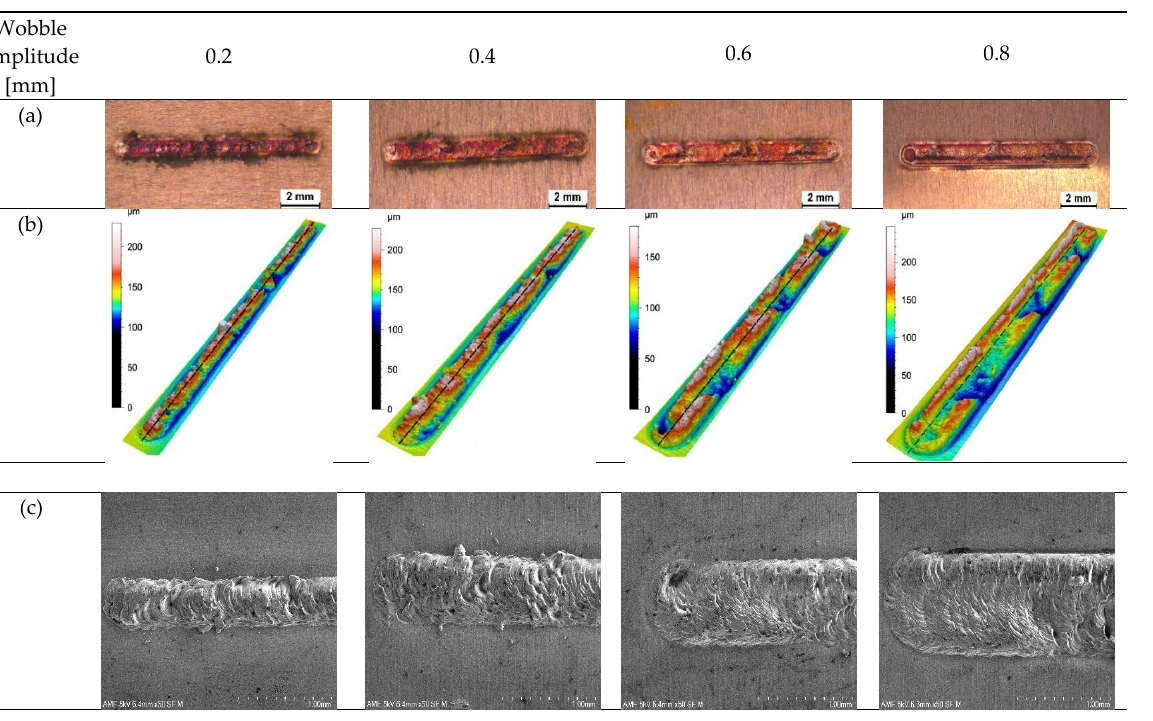
Figure 4. ( a ) Top view, ( b ) cross-section, and ( c ) 3D surface plot of the sample made without beam oscillation. Laser beam welding parameters were P = 750 W, PRR = 20 Hz, PW = 10 ms, V w = 2 mm/s, and gas flow = 15 L/min.